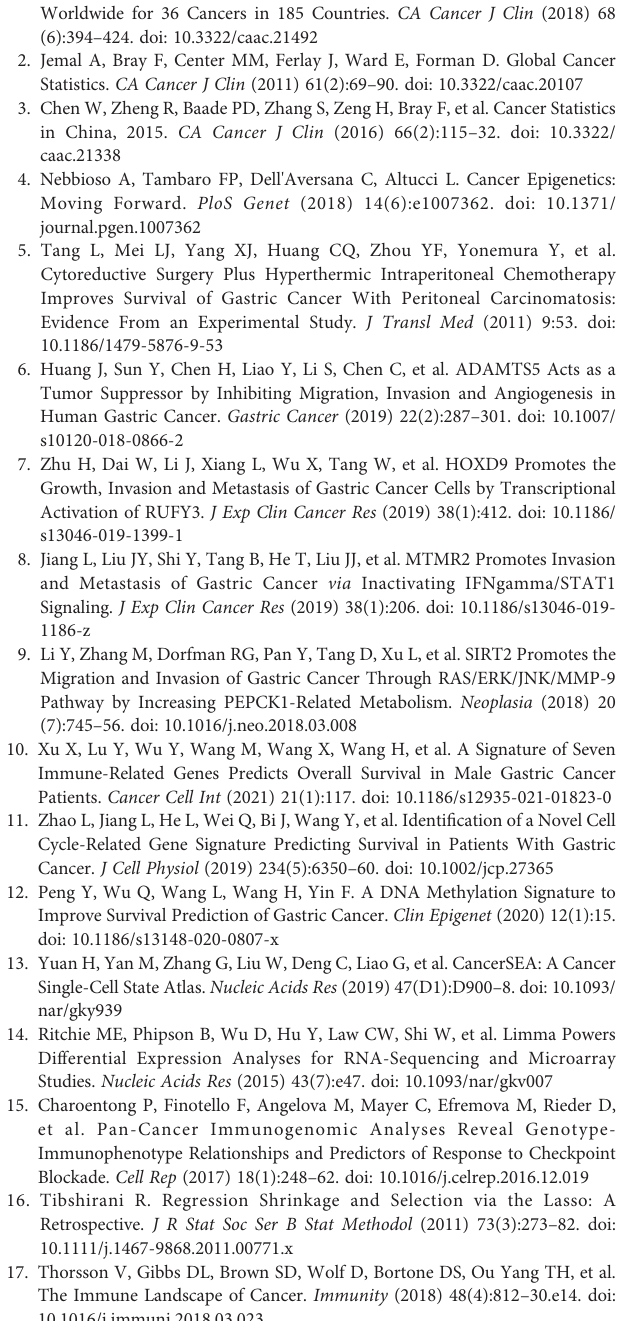
Supplementary Figure 2 | Comparison of the expression offour genes based on the TNM classi fi